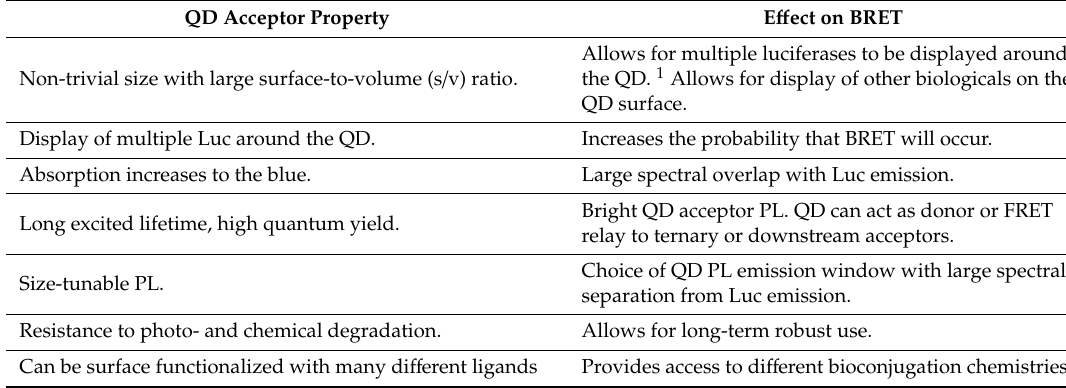
Table 1. Intrinsic QD physicochemical properties that augment their role as bioluminescence resonance energy transfer (BRET)